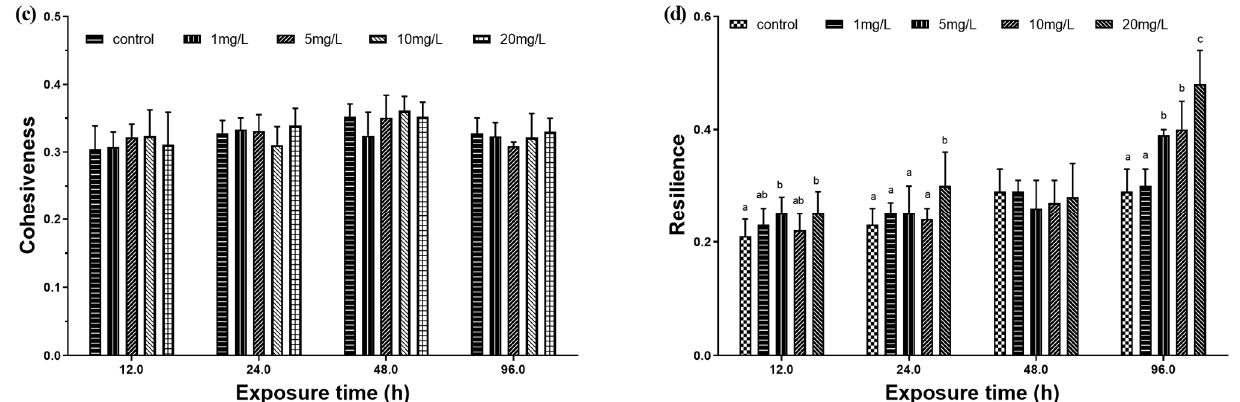
Figure 5. Muscle texture characteristics of M. amblycephala juveniles exposed to different nitrite concentrations from 12 h to 96 h. Data are expressed as mean ± SD (n = 3). ( a ) Hardness value; ( b ) springiness value; ( c ) cohesiveness value; ( d ) resilience value. Different letters represent significant differences among treatments ( p < 0.05).